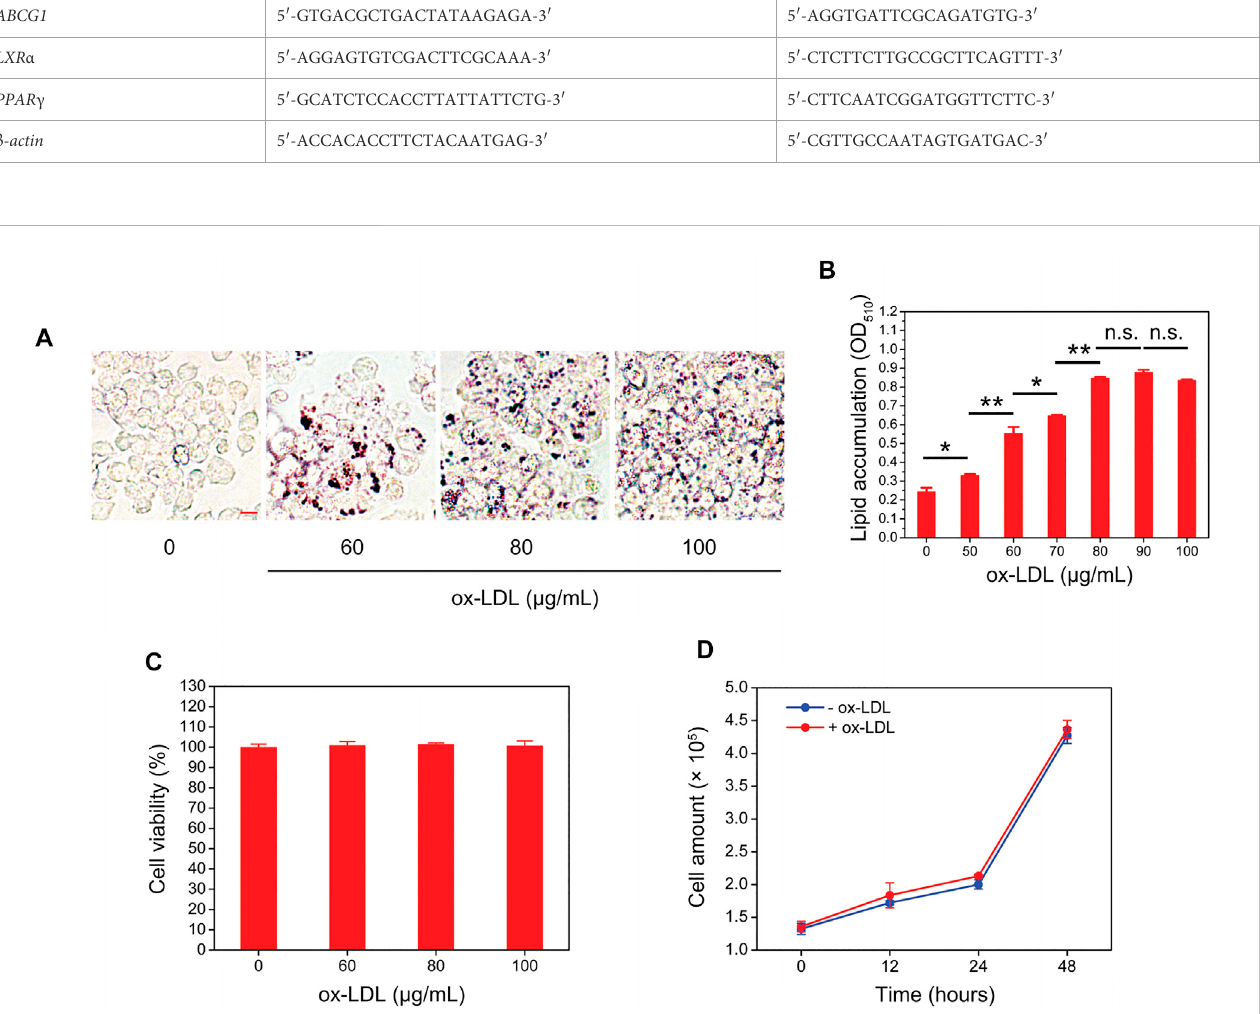
Ox-LDL induces the formation of foam cells by RAW264.7 macrophages. (A) RAW264.7 macrophages were incubated with ox-LDL at different concentrations for 24 h. After that, the intracellular lipid droplet content (red color) in RAW264.7 cells was determined by oil red O staining. Representative images of four individual ox-LDL concentrations (0, 60, 80, and 100 μ g/mL) are shown (×400 magni fi cation). Scale bar = 10 μ m (B) Quantitative results of different ox-LDL treatments were obtained by measuring the eluted oil red O dye at 510 nm using a spectrophotometer. (C) RAW264.7 cells were incubated with different concentrations of ox-LDL for 24 h, and cell viability was measured by using a Cell Counting Kit-8 (CCK-8). (D) RAW264.7 cells were treated with 80 μ g/mL ox-LDL for 48 h. At each indicated time point, the cell number was counted by using a hemocytometer. Values represent the mean ± SEM from three independent experiments. Signi fi cance is presented as * p < .05, ** p < .01 between the indicated groups. n. s.: no signi fi